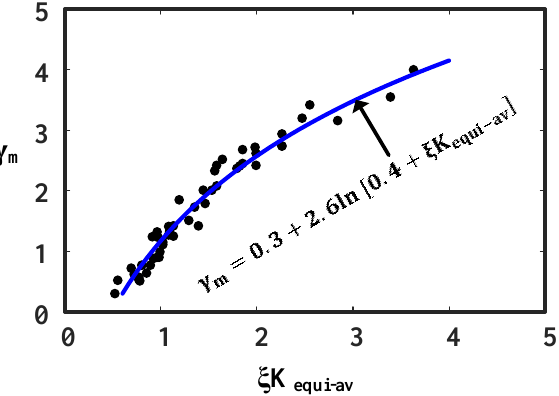
Figure 8. γ m versus ξK equi − av for ML-CFST beams.